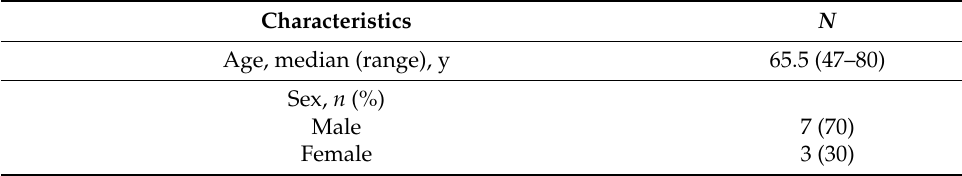
Table 1. Characteristics of 10 patients in the pancreatic juice